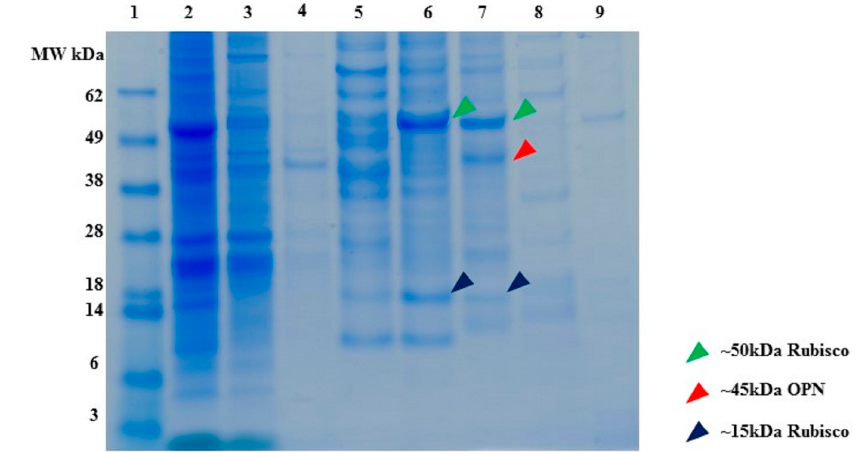
Figure 10. SDS-PAGE of C. reinhardtii lysate binding and elution profile from Capto Q (strong anion exchange) resin. All samples diluted to <1 mg/mL TSP. Lane 1 . MW marker, lane 2 . Clarified